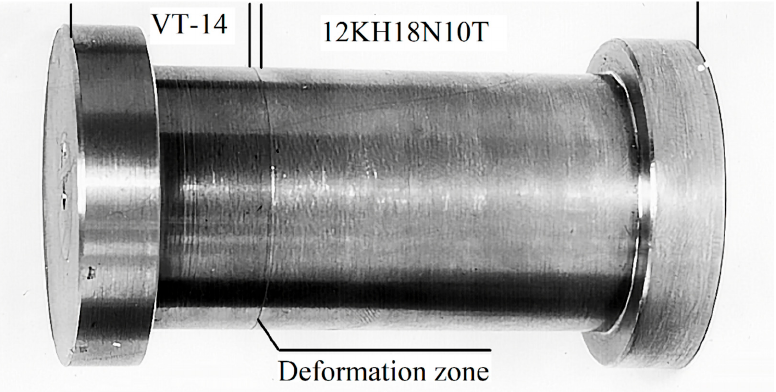
Figure 7. Sample for mechanical testing of the 12KH18N10T+Cu+Nb+VT-14 bimetallic adapter.